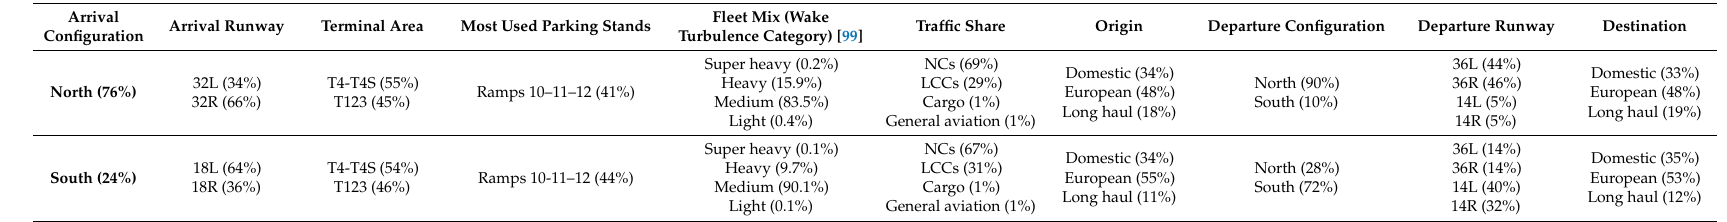
Table 5. Relevant features regarding traffic mix and infrastructure utilization for the case